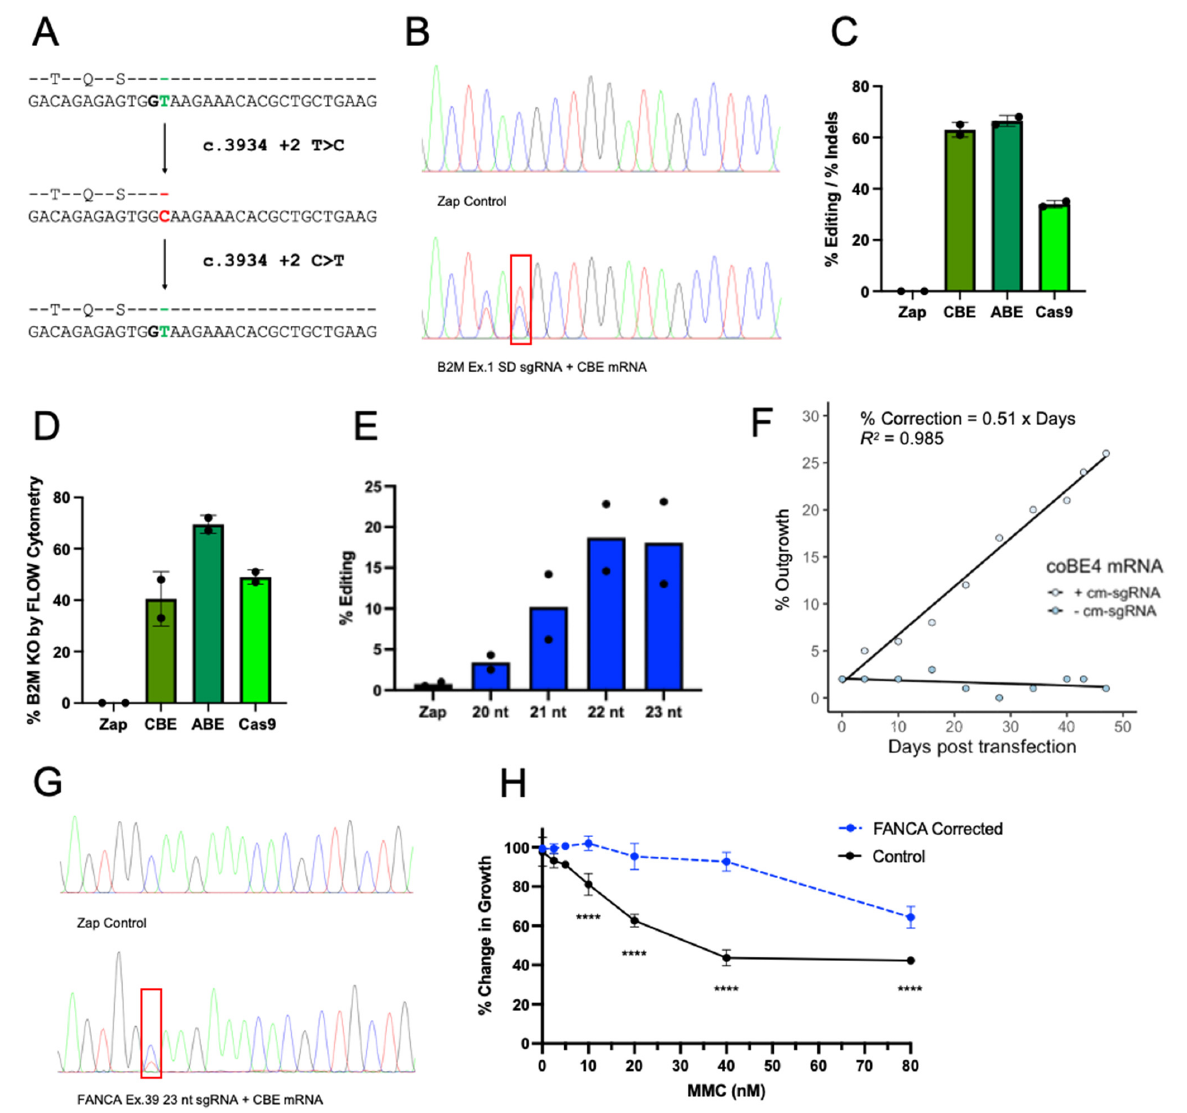
Figure 3. Cytosine base editing in FANCA c.3934 + 2T > C patient-derived fibroblasts and LCL. ( A ) Editing scheme; immediately following FANCA exon 39, a SD (GT) is disrupted by a + 2T > C mutation (CG). CBE directly converts C > T back to the WT sequence. ( B ) B2M Ex.1 SD sgRNA region chromatograms of Sanger sequencing after PCR amplification of B2M exon 1 using (http://baseeditr.com/, accessed on 1 January 2018–1 July 2022) [35]. ( C ) Percentage of B2M editing events (Kluesner and Nedveck et al. 2018) or indels (https://ice.synthego.com/#/, accessed on 1 January 2018–1 July 2022) identified by Sanger sequencing 5 days post electroporation. Data are represented as mean ± SD with n = 2 replicates. ( D ) Percentage of B2M protein KO as shown by flow cytometry 6 days post electroporation. ( E ) Percentage of FANCA editing events identified by Sanger sequencing after in vitro incubation of FANCA Ex. 39 amplicons, reverse FANCA Ex. 39 primers, and respective sgRNAs. Data are represented as mean ± SD with n = 2 replicates. ( F ) Correlation of editing (C > T) as identified by Sanger sequencing of FA fibroblasts corrected using CBE mRNA with FANCA c.3934 + 2T > C 22 nt sgRNA over time. Cell pellets were collected and analyzed on respective days up to 47 days in fibroblast media. ( G ) FANCA sgRNA region chromatograms of Sanger sequencing after PCR amplification of FANCA exon 39 using EditR. ( H ) MMC hypersensitivity in unedited (control) and edited FA fibroblasts (CBE mRNA + FANCA c.3934 + 2T > C 22 nt sgRNA) after 9 days in culture. Data are represented as mean ± SD with n = 3 replicates. Two-way ANOVA followed by Sidak’s multiple comparison test (**** p <